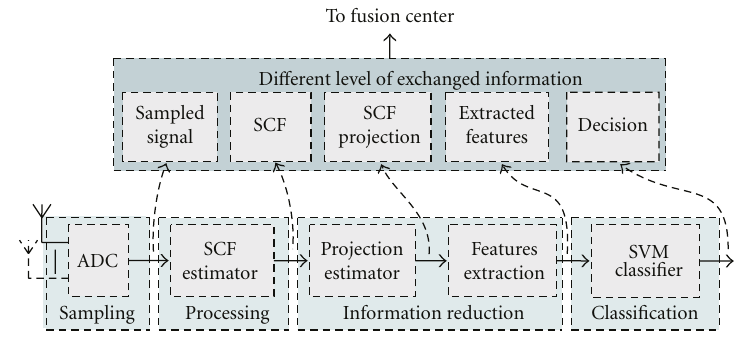
Figure 2: Block diagram for the spectrum sensing algorithms for the considered